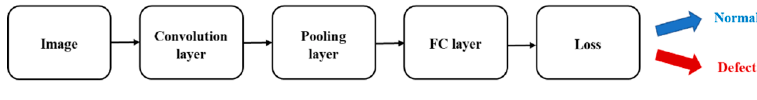
Figure 9. Basic flow chart of CNN (ConvNet).